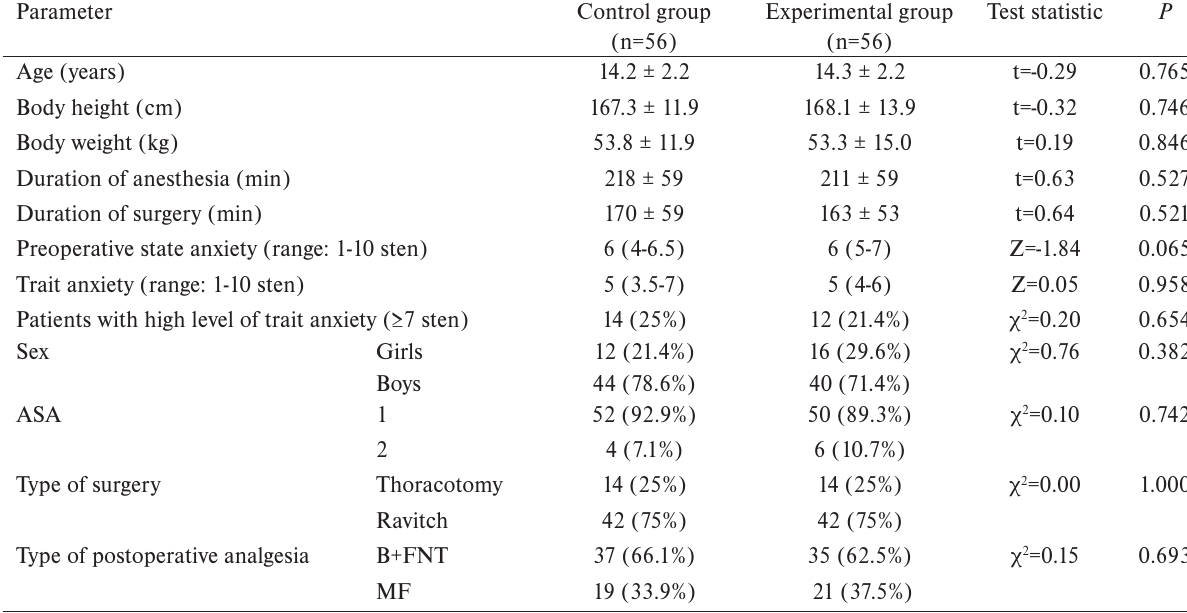
Table 1. Comparison of patients from the control and experimental group in terms of demographic and clinical characteristics.